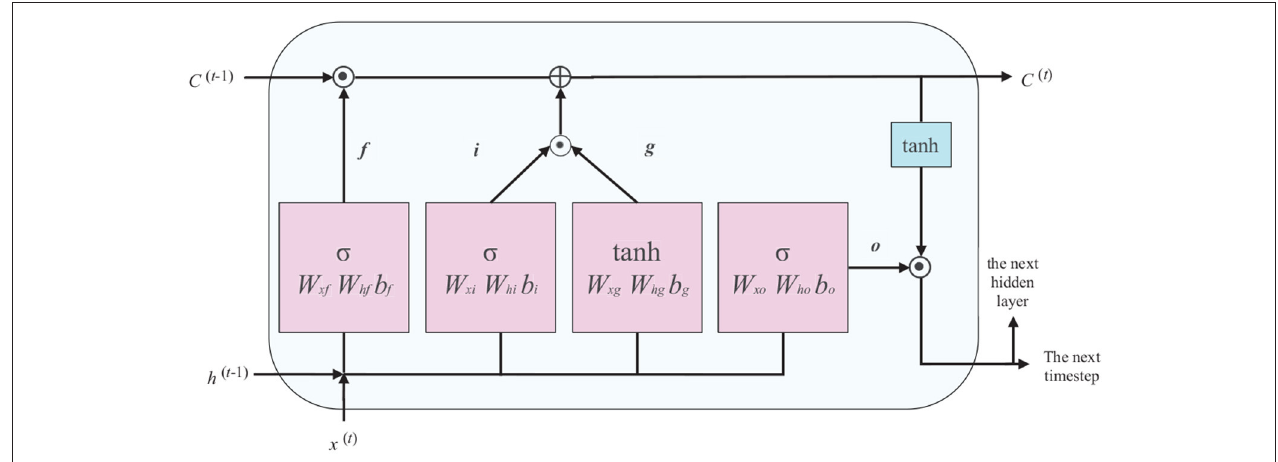
FIGURE 1 | Deployment structure of long short-term memory (LSTM) unit.